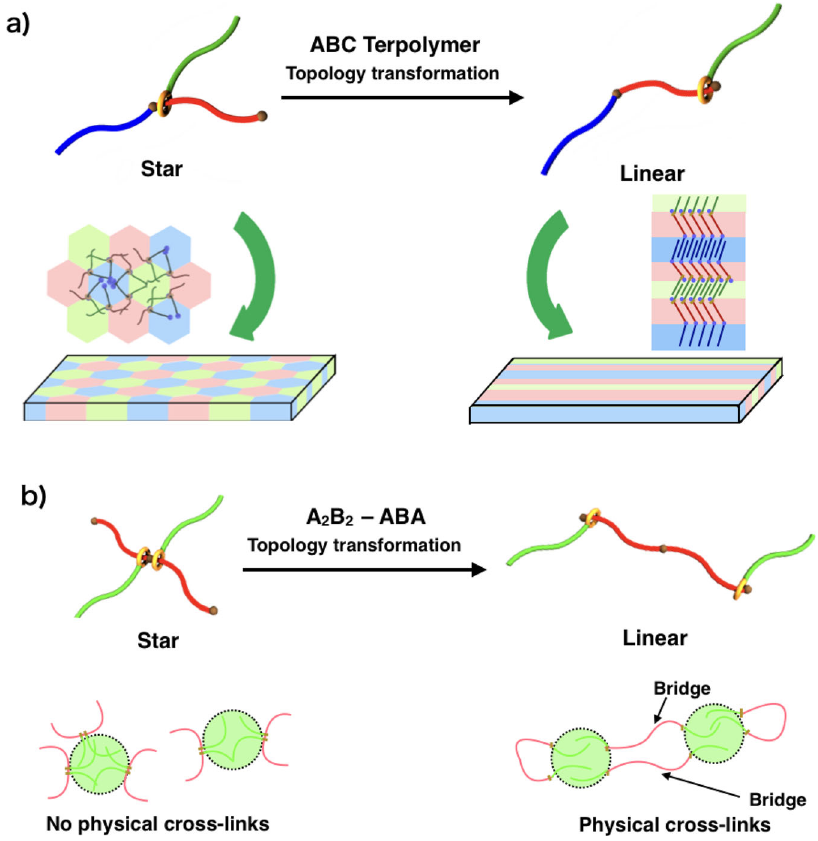
Fig. 1 Two types of topology-transformable block copolymers. a A rotaxane-linked star ABC terpolymer designed to undergo a change in its microphase- separated structure and visually demonstrate the concept of topology-transformable polymers. b An A 2 B 2 tetra-block copolymer designed to demonstrate a change in its mechanical properties via topology